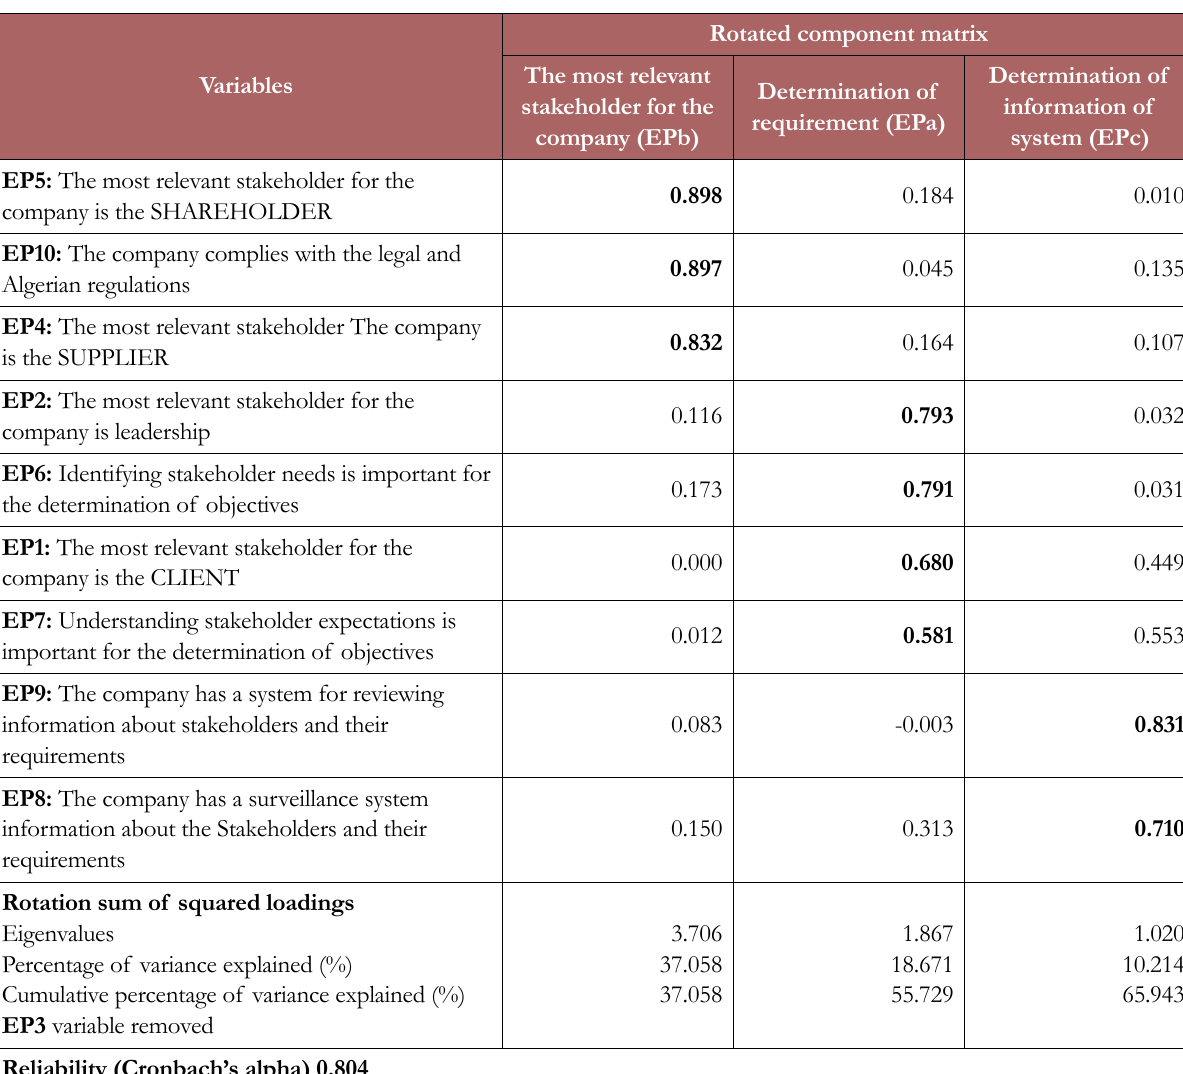
Table 5. EFA of the EP